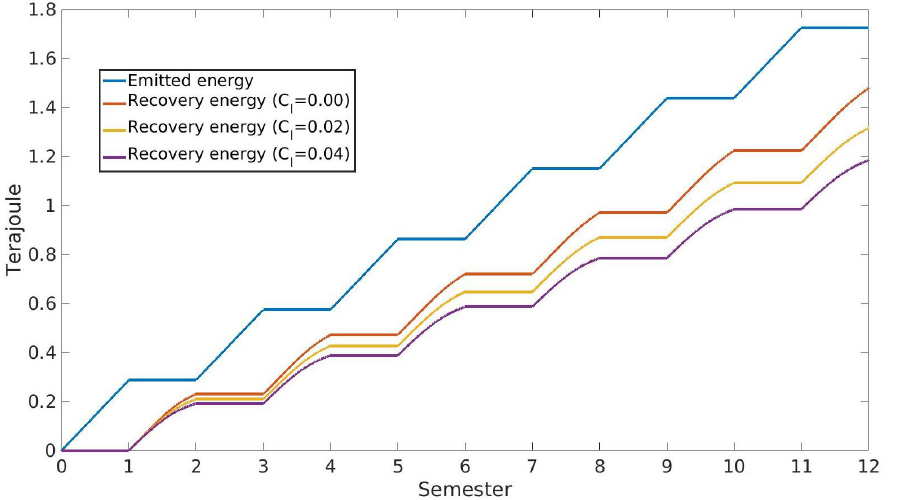
Figure 5. Comparison between the total emitted EM energy and recovered energy over time. Table 2. Comparison of relative amounts of recovered, residual stored, and lost energy. C l = 0 C l = 0.02 C l = 0.04 Yr. Rec. R. St. Lost Rec. R. St. Lost Rec. R. St. Lost 1 81.1% 18.9% 0%